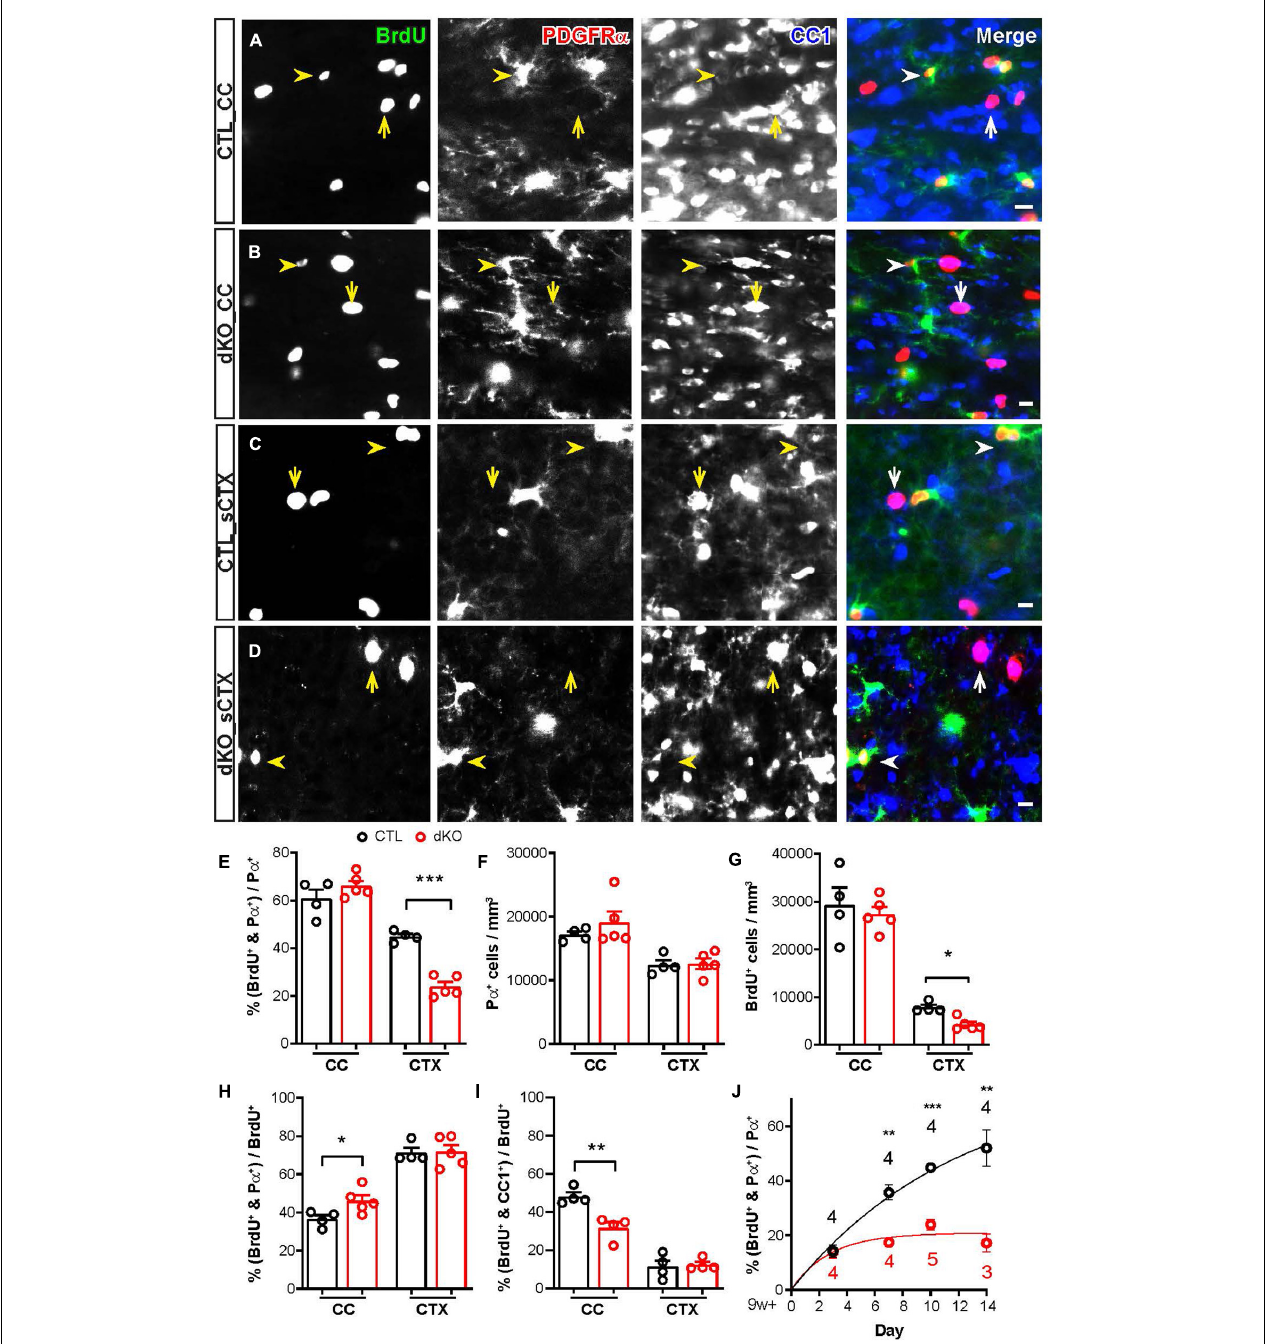
FIGURE 2 | Conditional gene ablation of Cav1.2 and Cav1.3 inhibited the proliferation of NG2 glia in the cortex. (A–D) Epifluorescence images showing BrdU + cells immunoactivity to PDGFR α or CC1 in the CC (A,B) and sCTX (C,D) of control and dKO mice. (E) The percentages of proliferating NG2 glia in the white and gray matter. In the gray matter, the number of proliferating NG2 glia from dKO mice was much lower than controls. Each datapoint represents results obtained from a single mouse. (F) Densities of the NG2 glia populations in control and mutant mice remained similar in various brain regions. (G) The density of proliferating NG2 glia in the CTX was significantly decreased. (H,I) The proportion of proliferating NG2 glia (H) in the CC was higher than controls, while the proportion of proliferated oligodendrocytes (I) in the CC was lower than controls. No difference could be detected in the gray matter. (J) The cumulative labeling of NG2 glia in the somatosensory cortex showed that a small proportion of still proliferating NG2 glia. The numbers in the graph represent mouse number. * p < 0.05; ** p < 0.01; *** p < 0.001.